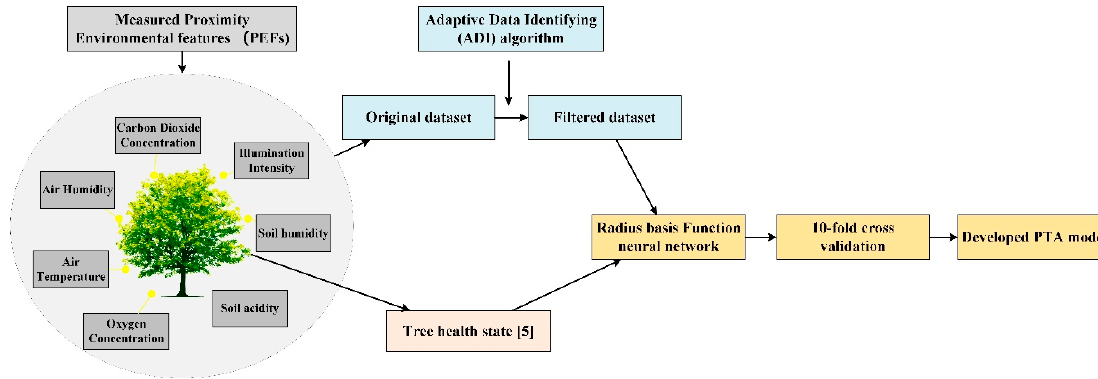
Figure 1. The PTA algorithm.